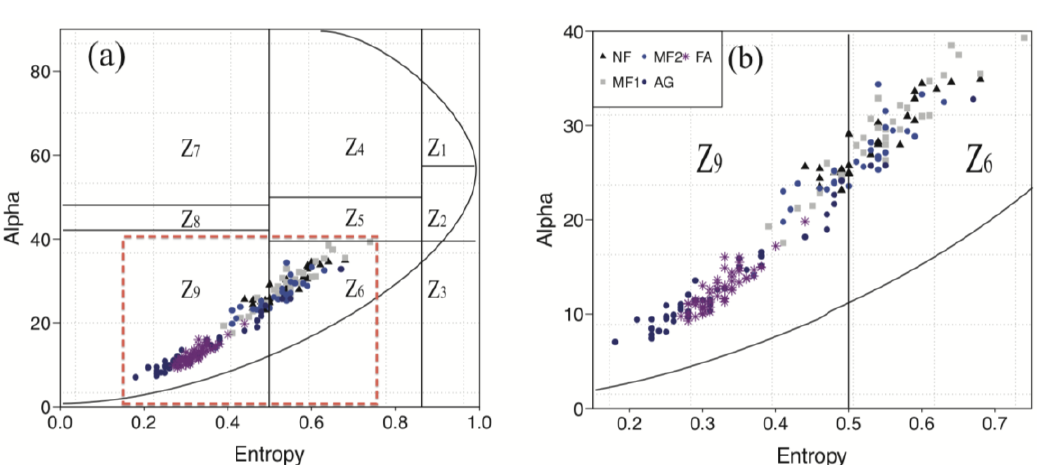
and 𝑍 are dominated by surface 6 9 , 𝑍 and 𝑍 by multiple scattering 1 4 7